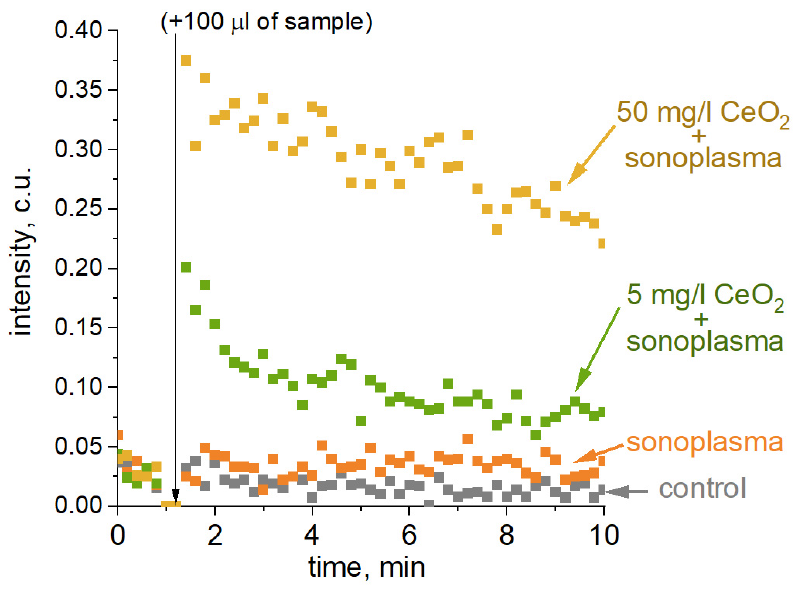
Figure 6. L-012 chemiluminescence for the samples (from bottom to top): control (phosphate buffer); municipal water; municipal water with 5 mg/L CeO 2 ; municipal water with 50 mg/L CeO 2 . Chemiluminescence measurements were started 1 hour after one cycle of sonoplasma treatment.